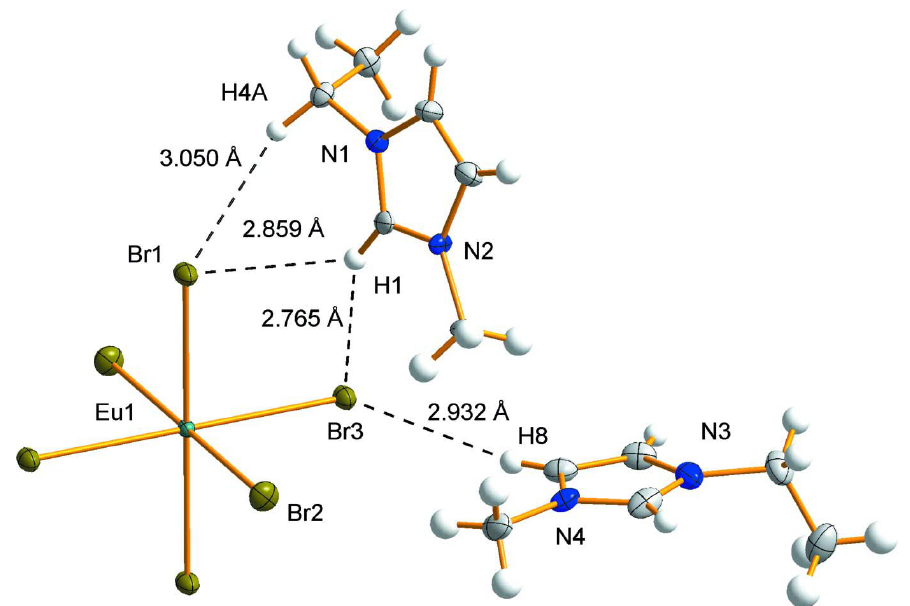
Figure 1 ] 3- anion and interactions to two exemplary [EMIM] + cations around Eu1 in the crystal structure of Structure of the [EuBr 6 [EMIM] [EuBr ]. The dashed lines indicate the hydrogen bonding interactions. Displacement ellipsoids are shown at the 3 6 50% probability level and H-atoms are drawn as small circles of arbitrary